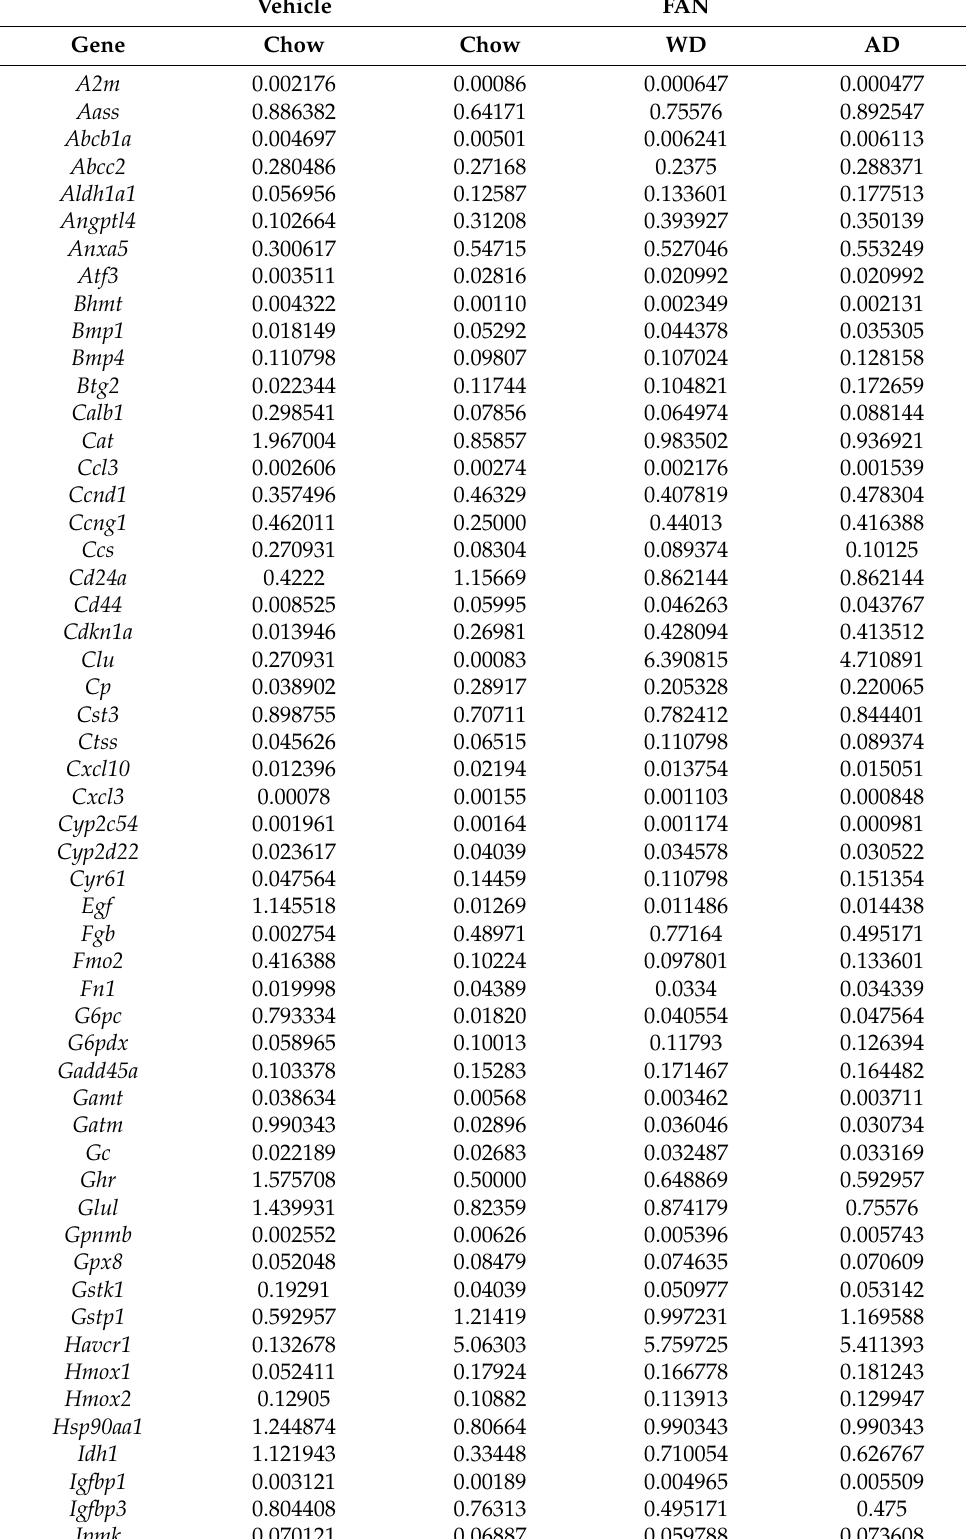
Table A3. Raw RT 2 Nephrotoxicity Array